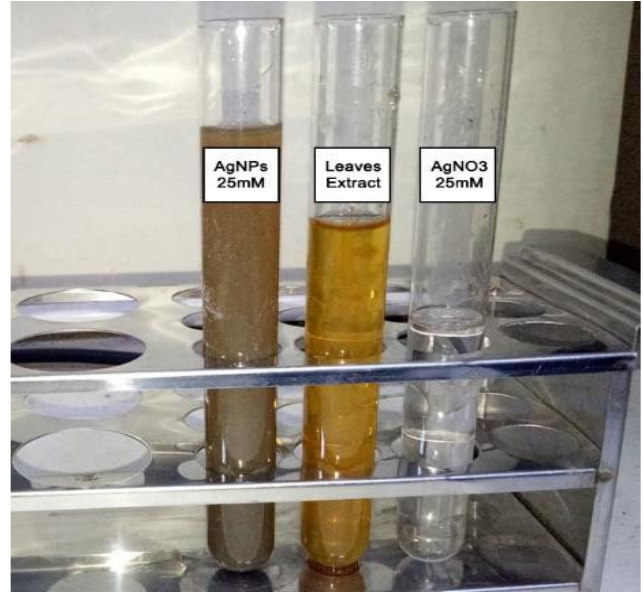
Figure 1. Indication of color change after reduction of AgNO3.